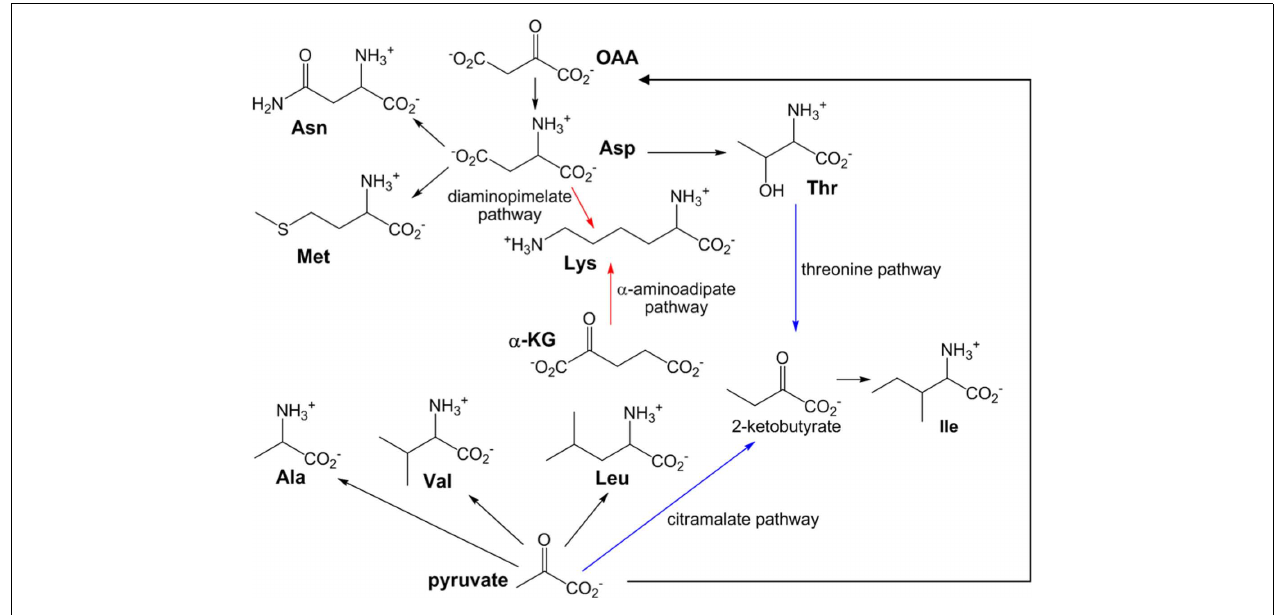
The pathways for isoleucine and lysine biosynthesis are shown in blue and red, respectively. Phototrophic bacteria have not yet been known to synthesize lysine via the α -aminoadipate